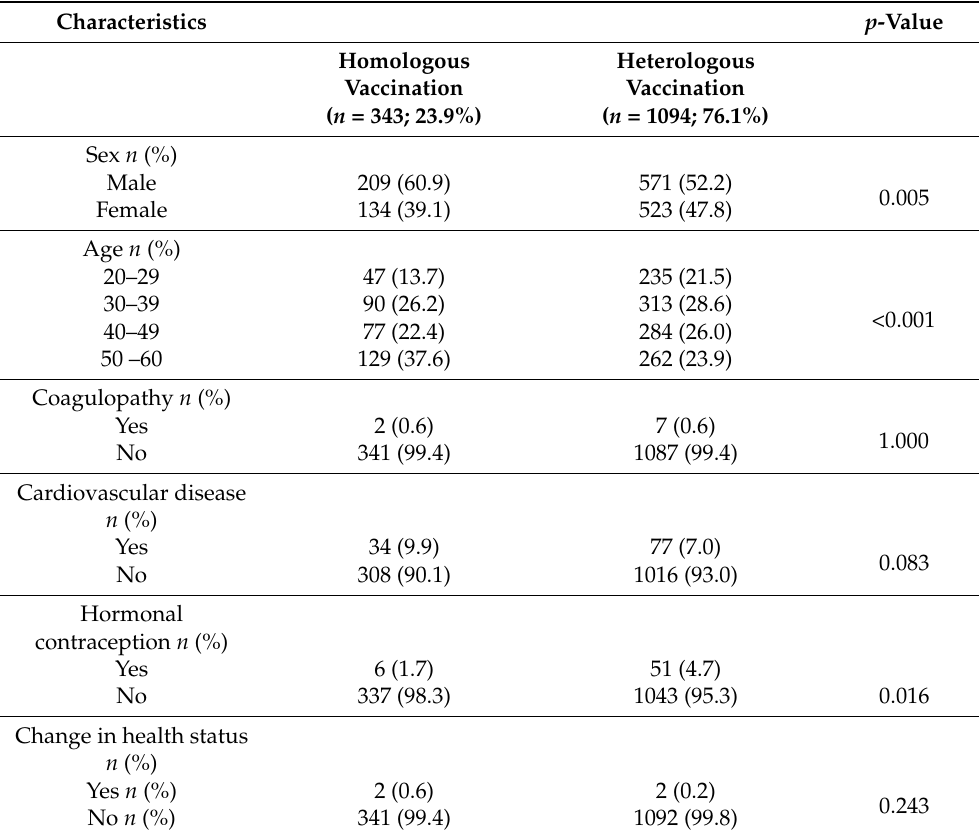
Table 1. Participants according to the vaccination regimen